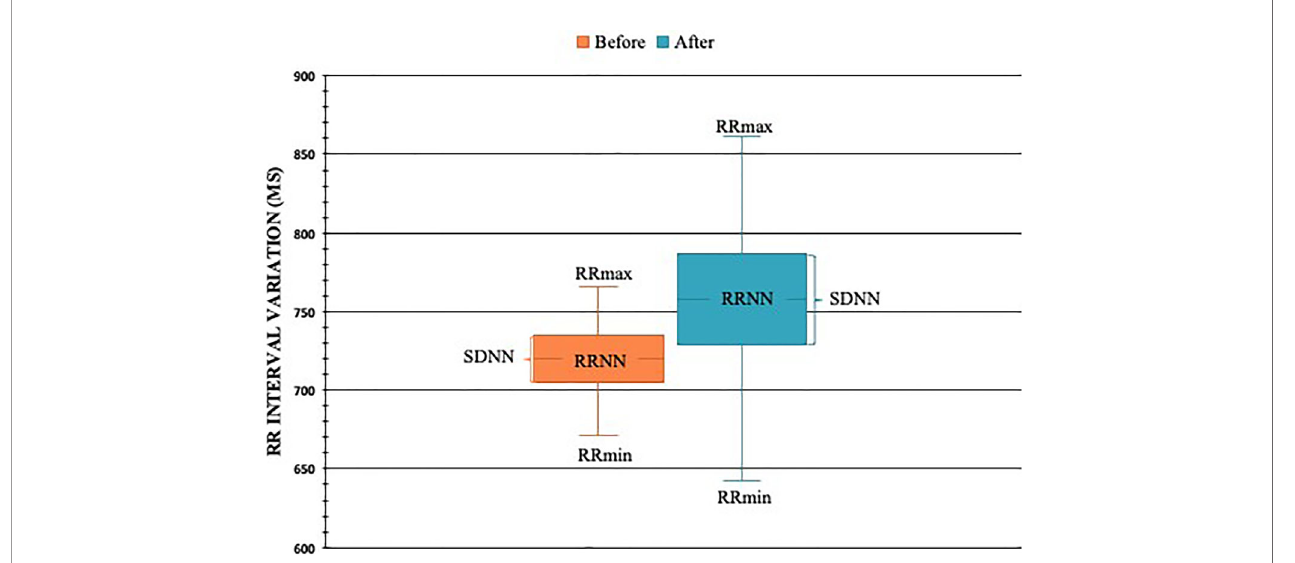
FIGURE 3 | RR interval in milliseconds (ms) before and after VD supplementation in T1DM patients with CAN (N=23). * = p < 0.05. RRNN, mean of RR intervals at rest; SDNN, standard deviation of RR intervals; RRmin, minimum RR interval observed; RRmax, maximum RR interval observed.